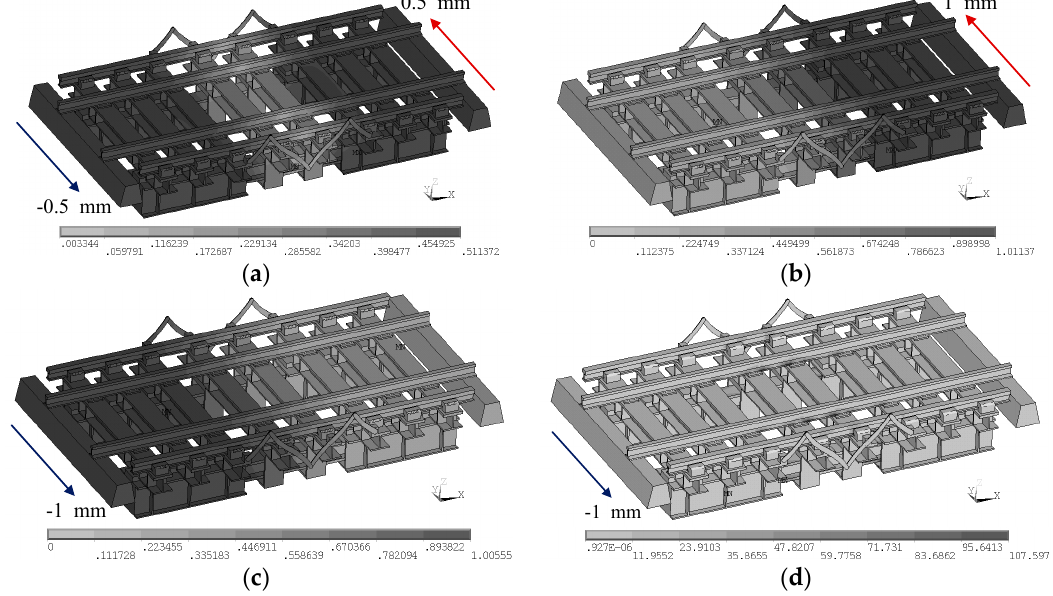
Figure 12. Mechanical contours of the expansion device under 1 mm relative transverse displacement: ( a ) displacement contour under − 0.5 mm on the fixed side and +0.5 mm on the free side (unit: mm); ( b ) displacement contour under +1 mm on the free side (unit: mm); ( c ) displacement contour under − 1 mm on the fixed side (unit: mm); ( d ) stress contour under − 1 mm on the fixed side (unit: MPa).